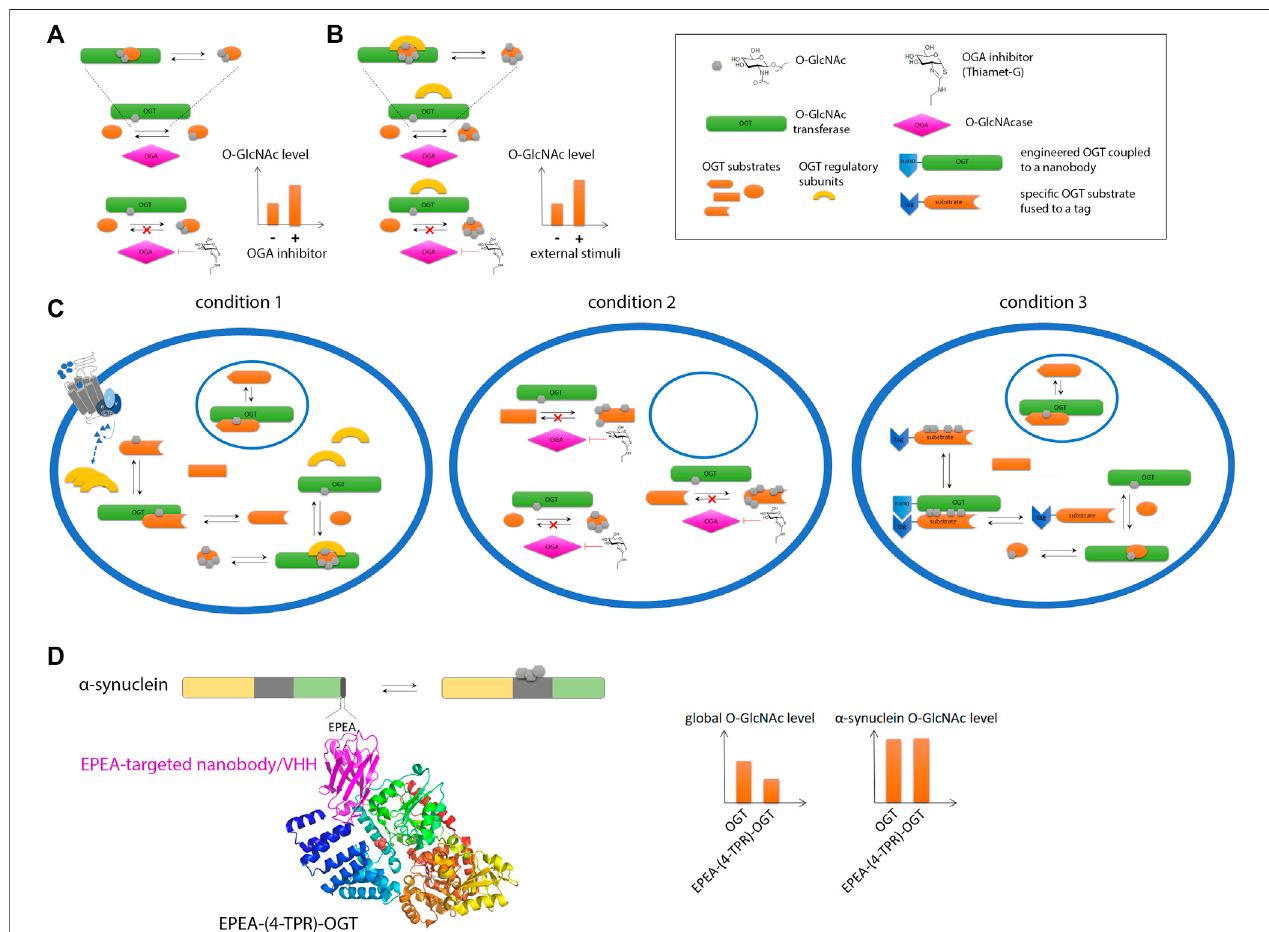
FIGURE 12 | Modulation of O-GlcNAc modi fi cation of proteins by proximity-induced protein glycosylation using nanobody-OGT protein engineering. (A) Schematic representation of the O-GlcNAc dynamics regulated by single OGT and OGA enzymes, and modulation of OGA activity by an OGA inhibitor such as Thiamet G contributing to overall increased O-GlcNAc levels. (B) As OGT is the unique O-GlcNAc transferase in human, it has been suggested that it may act with regulatory subunits that address OGT to speci fi c substrates depending on external stimuli and increase protein-speci fi c O-GlcNAc levels. Treatment with Thiamet-G by increasing overall O-GlcNAc levels may contribute to increase protein-speci fi c O-GlcNAc level. (C) Modulation of protein O-GlcNAc levels in cell or animal models. Condition 1, external stimuli and signal transduction lead to the expression of protein-speci fi c regulatory subunits of OGT that increase its activity on selected proteins; condition 2, overall increase of protein O-GlcNAc levels upon treatment with Thiamet-G; condition 3, selected increase of O-GlcNAcylation of a target substrate by a nanobody fused to OGT targeting a speci fi c protein tag. (D) This latter method (C, condition 3) was further extended to O-GlcNAcylation of endogenous α -synuclein using a nanobody-OGT targeting α -synuclein EPEA C-terminal sequence (Ramirez et al., 2020). EPEA-(4-TPR)-OGT refers to a truncated form of OGT containing 4 tetratricopeptide repeats fused to a nanobody targeting the EPEA sequence of α -synuclein. The TPR truncation of OGT limits the overall increase of O-GlcNAc levels while OGT coupling to a nanobody targeting the EPEA sequence increases the selectivity for α -synuclein. This approach leads to a selective elevation of α -synuclein O-GlcNAc